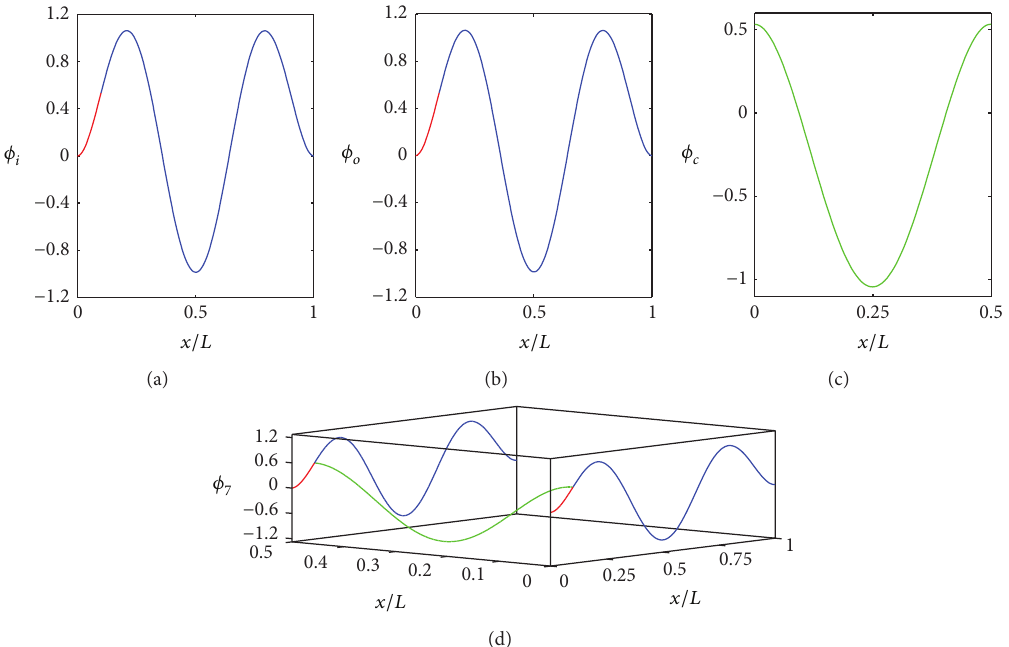
Figure 8: Seventh mode shape of the filter: (a) input, (b) output, (c) coupling beams, and (d) combination of (a), (b), and (c).